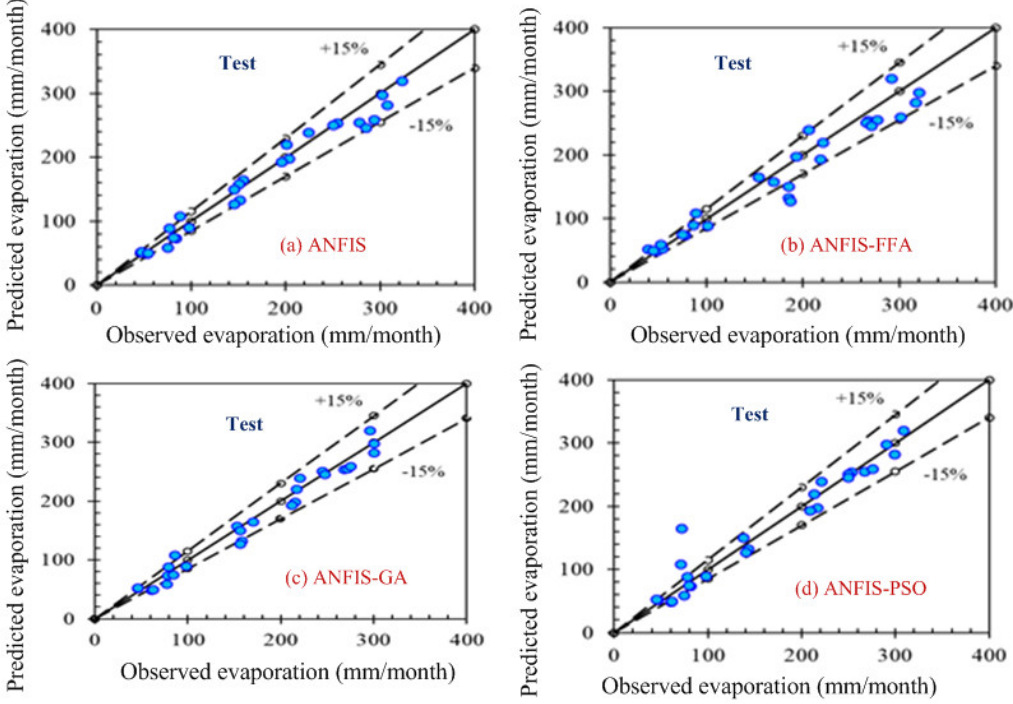
Figure 6. Comparison of the target and obtained output sample index of the test data for ( a ) ANFIS, ( b ) ANFIS–FFA, ( c ) ANFIS–GA, and ( d ) ANFIS–PSO, respectively (first combination of the data set).